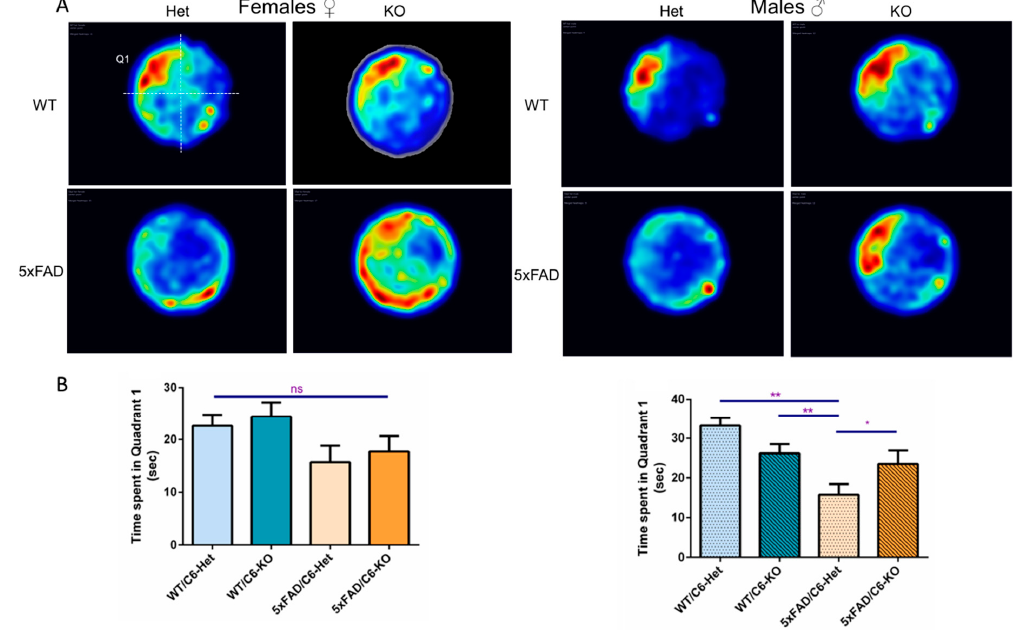
Figure 3. Caspase-6 KO in 5xFAD mice improves searching pattern in the probe test. On the fifth day of the MWM test, the platform was removed, and mice were released from the furthest position to quadrant #1 (Q1).